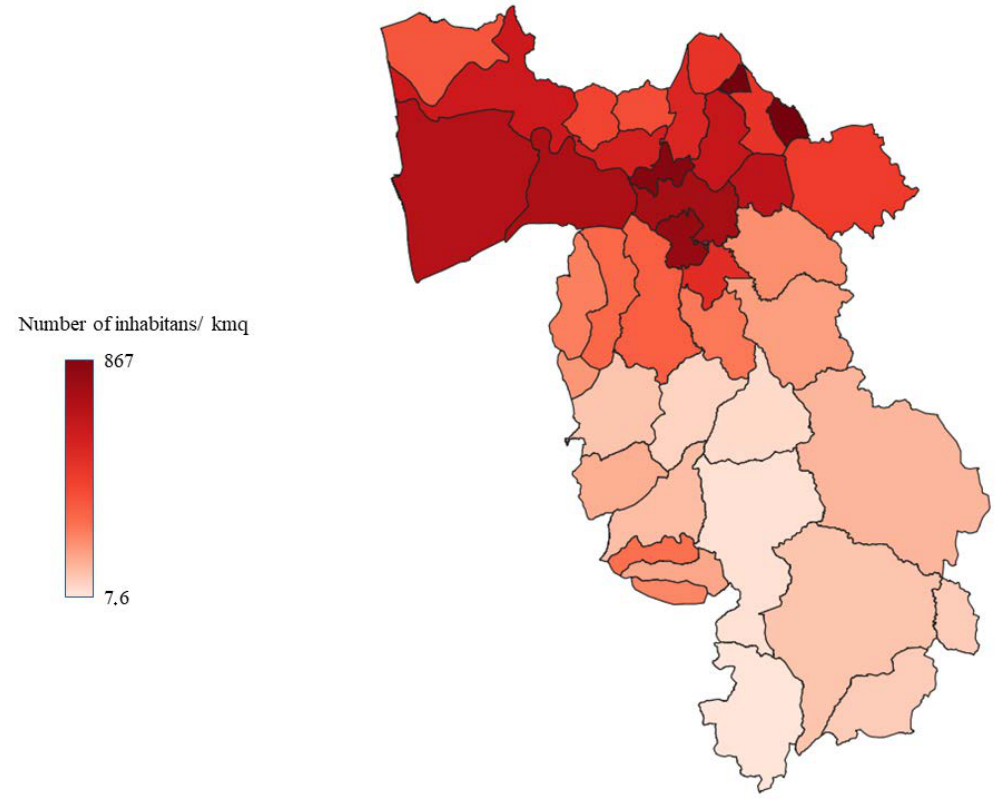
Figure 3. Municipalities in the province of Pisa classified according to population density.